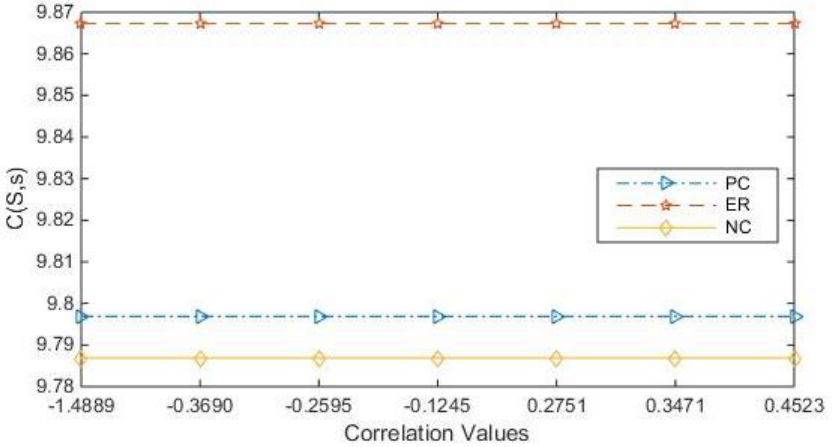
Figure 2. Ordinary customer arrival correlation vs. total cost rate.